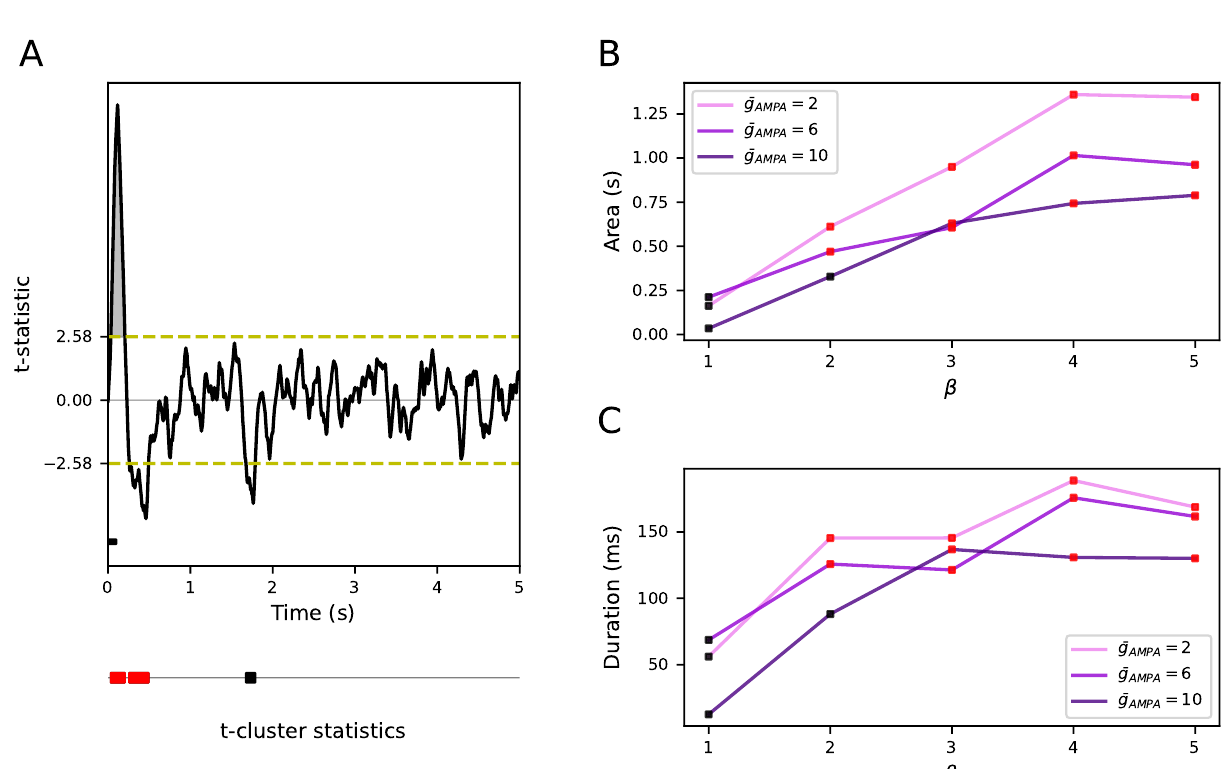
Figure 6. Information propagation as a function of β and ¯ g AMPA . ( A ) Example of extraction of t-cluster statistics when comparing the evoked responses in firing rate signals with the spontaneous activity in the prestimulus intervals at ¯ g AMPA = 2 and β = 5. The yellow horizontal dashed line defines the critical t-value. The concatenation of consecutive t-values above and below this threshold that forms the t-cluster statistics is shown as rectangles in the bottom line. Significant and non significant t-cluster statistics are indicated in red and black, respectively. The area and duration of the first t-cluster statistic, shown in gray, are used to quantify response propagation to the unperturbed population. Stimulus duration is represented by a black horizontal line. ( B ) Changes in the area of the first significant t-cluster statistic in seconds (y-axis) with respect to β (x-axis). ( C ) Changes in the length of the first significant t-cluster statistic in milliseconds (y-axis) with respect to β (x-axis). Violet, dark violet and indigo correspond to ¯ g AMPA = 2, ¯ g AMPA = 6 and ¯ g AMPA = 10, respectively. Figures show that the propagated information to the unperturbed population depends on β . Increasing ¯ g AMPA from 2 to 10 and keeping β = 1 does not lead to a significant cluster in the unperturbed population (black squares). Increasing β from 1 to 3 shows a significant cluster (red squares) in all values of ¯ g AMPA . In the case of ¯ g AMPA = 2, the t-cluster statistics are significant ( p < 0.001) for β = 2, 3, 4 and 5. In the case of ¯ g AMPA = 6, the t-cluster statistics are significant ( p < 0.003) for β > 1. In the case of ¯ g AMPA = 10, the t-cluster statistics are significant ( p < 0.001) for β >